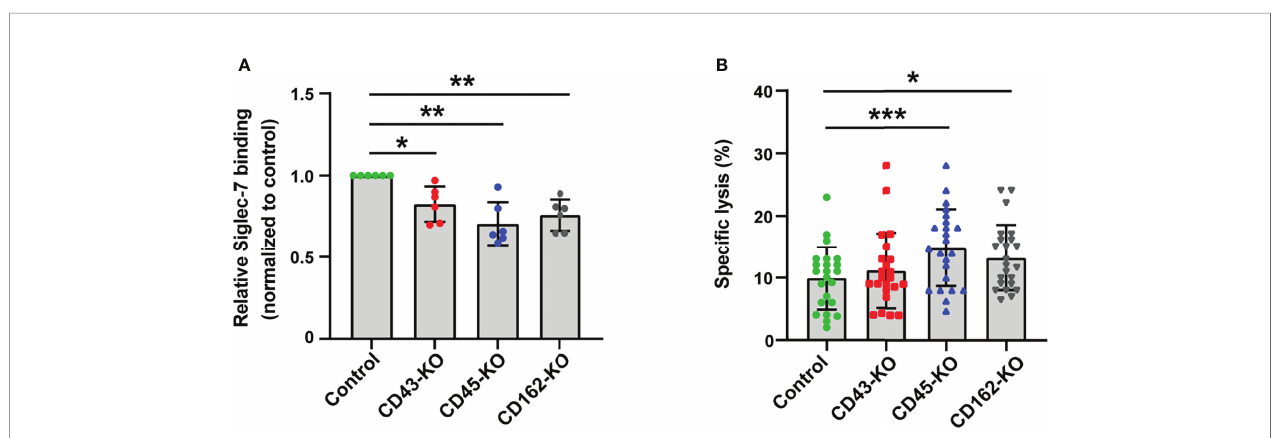
FIGURE 3 | CD43, CD45, and CD162/PSGL-1 are the counterreceptors of Siglec-7. (A) Effect of glycoprotein knockout (KO) on Siglec-7 – Fc binding. The glycoprotein genes ( SPN , PTPRC , and SELPLG – encoding CD43, CD45, and CD162/PSGL-1, respectively) in JVM-3 were disrupted with CRISPR – Cas9 technology, and the cells were subjected to staining with Siglec-7 – Fc. The disruption of individual genes led to a small but reproducible reduction in Siglec-7 – Fc binding. Data was normalized by the Siglec-7 – Fc binding (in MFI) to control JVM-3 cells. * P < 0.05, and ** P < 0.01, one-way ANOVA with Dunnett ’ s post hoc test. Bars represent mean ± SD of 6 independent experiments. (B) Effect of glycoprotein KO on NK cell cytotoxicity. Glycoprotein KO and control JVM-3 cells were subjected to NK cell cytotoxicity assay. Disruption of CD45 and CD162/PSGL-1 led to increased sensitivity to NK cytotoxicity. A trend toward increased sensitivity of CD43 KO cells to NK cytotoxicity was observed, but it was not statistically signi fi cant (* P < 0.05 and *** P < 0.001, repeated-measures one-way ANOVA with Dunnett ’ s post hoc test). Bars represent mean ± SD of 23 independent